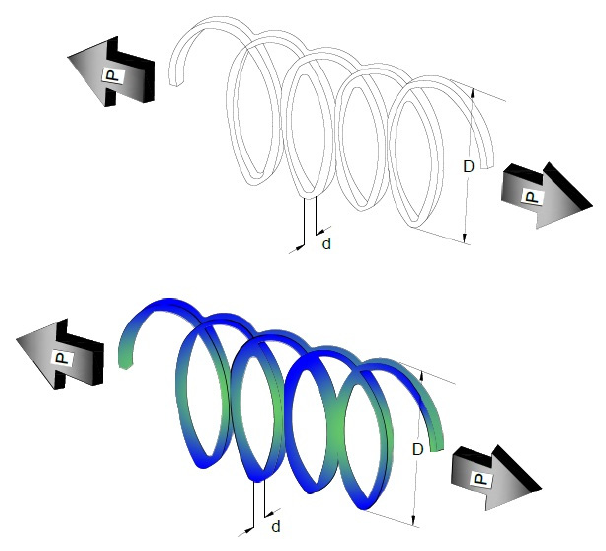
Figure 9. Tension/compression spring problem [47]. Table 17. Minimization results of tension/compression spring design.